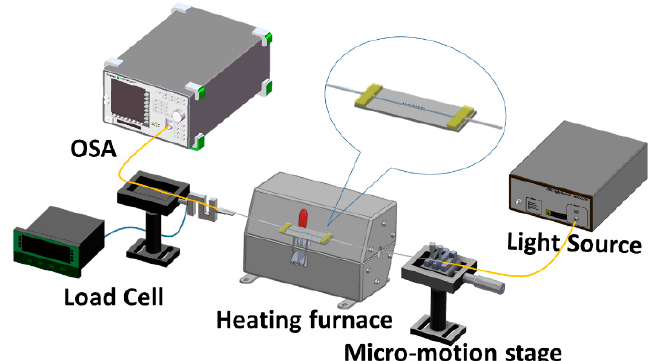
Figure 3. Schematic of the experimental setup for the long-period fiber grating (LPFG) sensor in the temperature detection experiment.